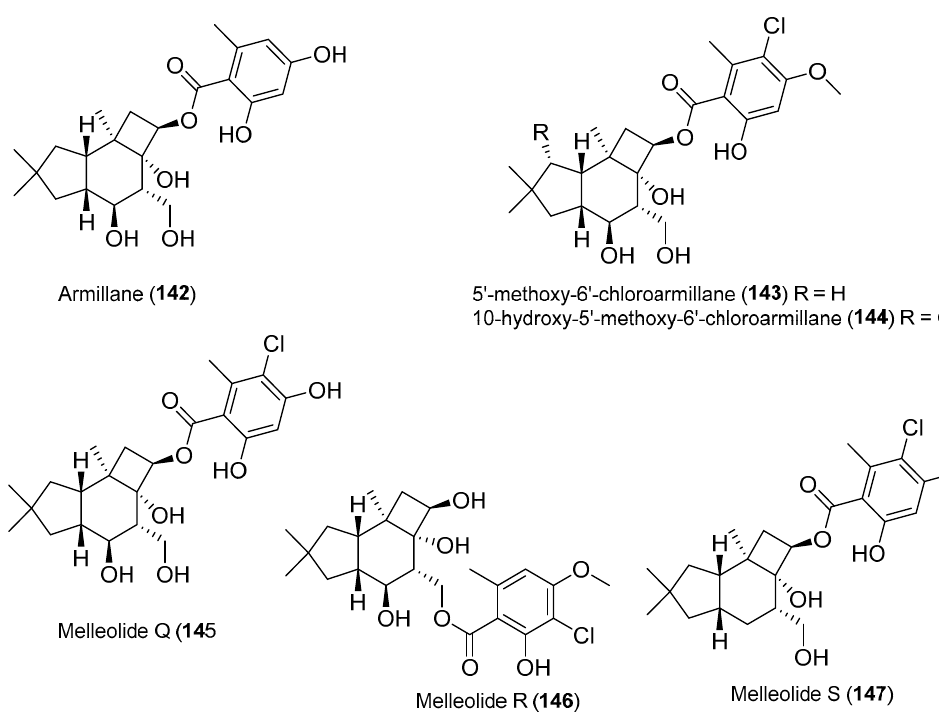
Figure 22. Structures of saturated protoilludane-containing aryl sesquiterpenoids 142 – 147 isolated from Armillaria